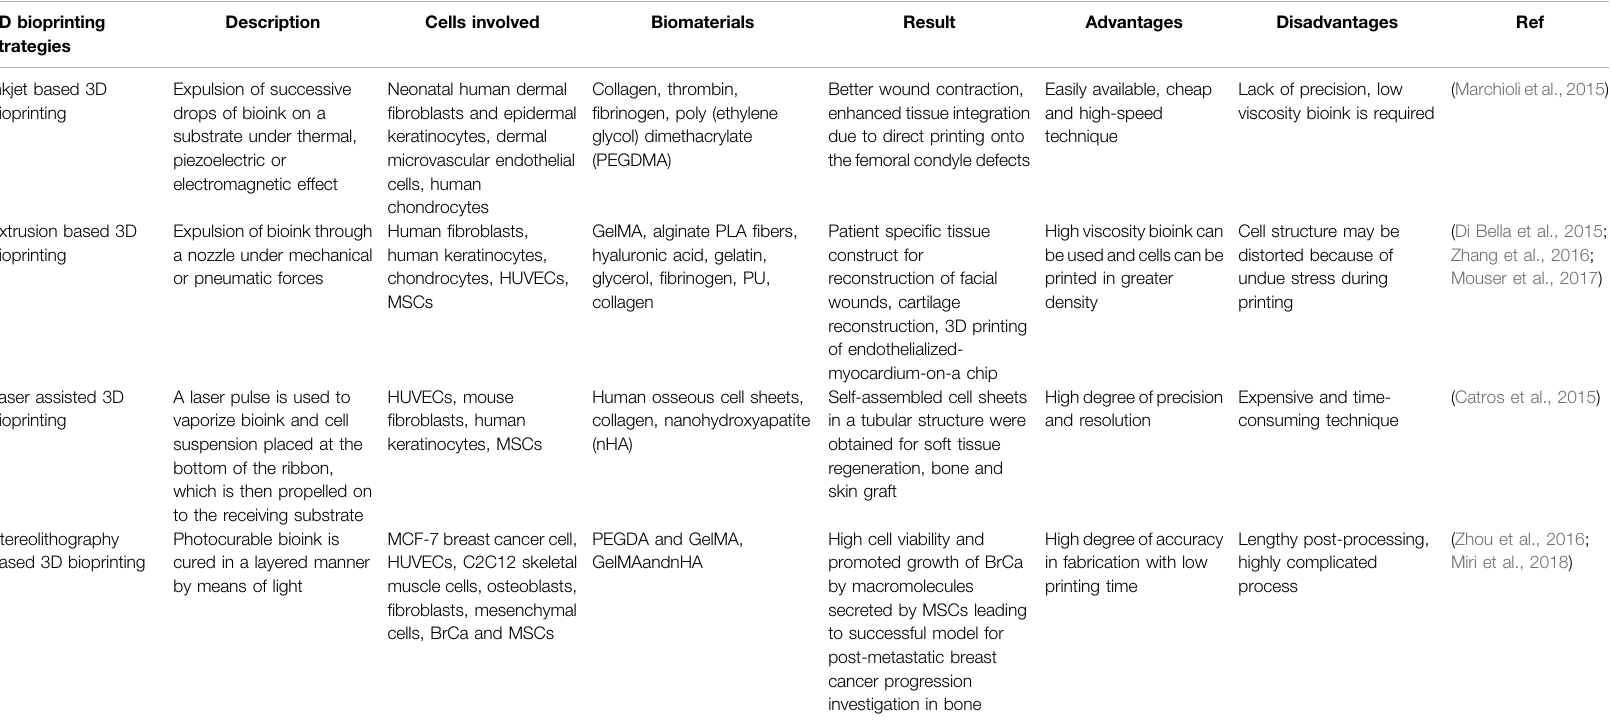
TABLE 1 | Comparative summary of different 3D bioprinting